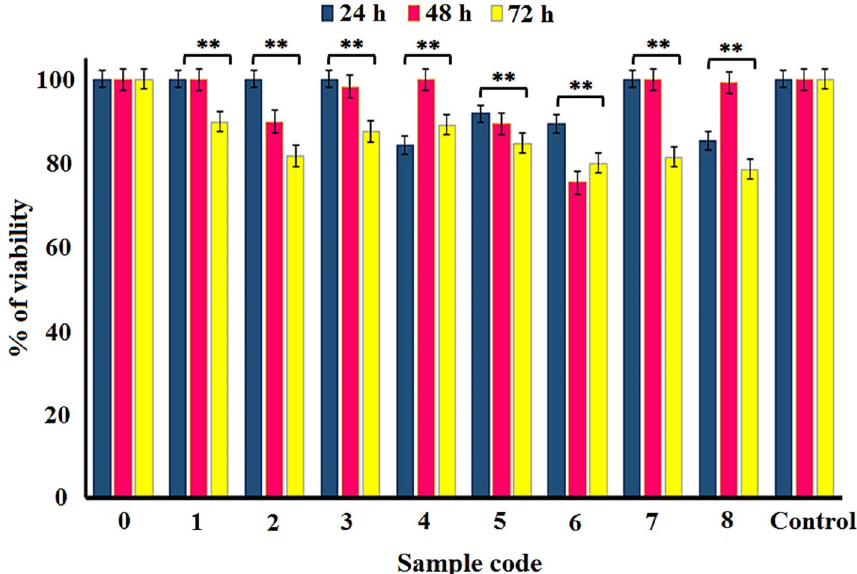
Figure 10. Comparison of cytotoxicity of uncoated and coated fabrics towards HEK 293 cells after 24, 48, and 72 h of exposure, ** P < 0.05. Sample 0 (Uncoated fabric), Samples 1–4 and 5–8 (NS-coated fabrics at 2, 10, 20, and 50 mM silver nitrate concentrations, and 25 and 50 min sonication time,